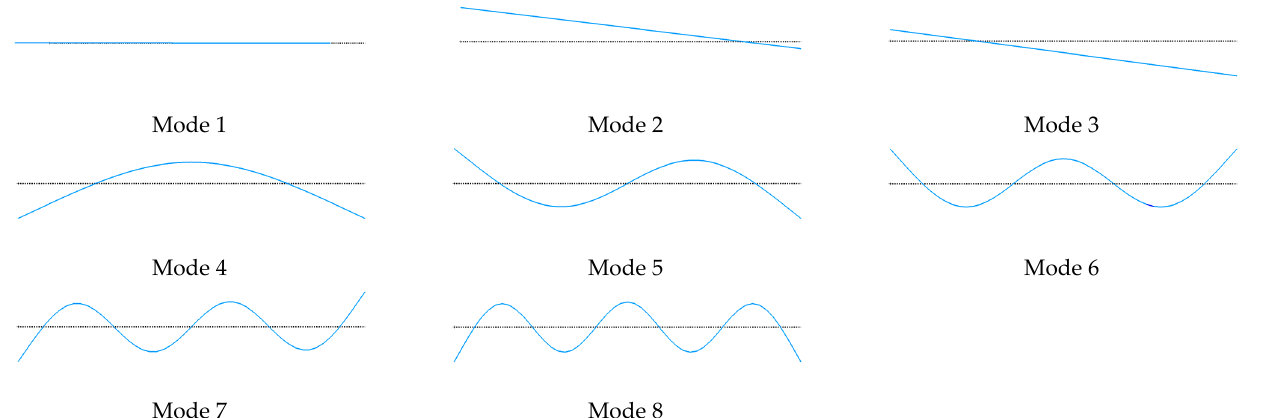
Figure A3. Rigid-body mode and first five elastic modes with BC3: